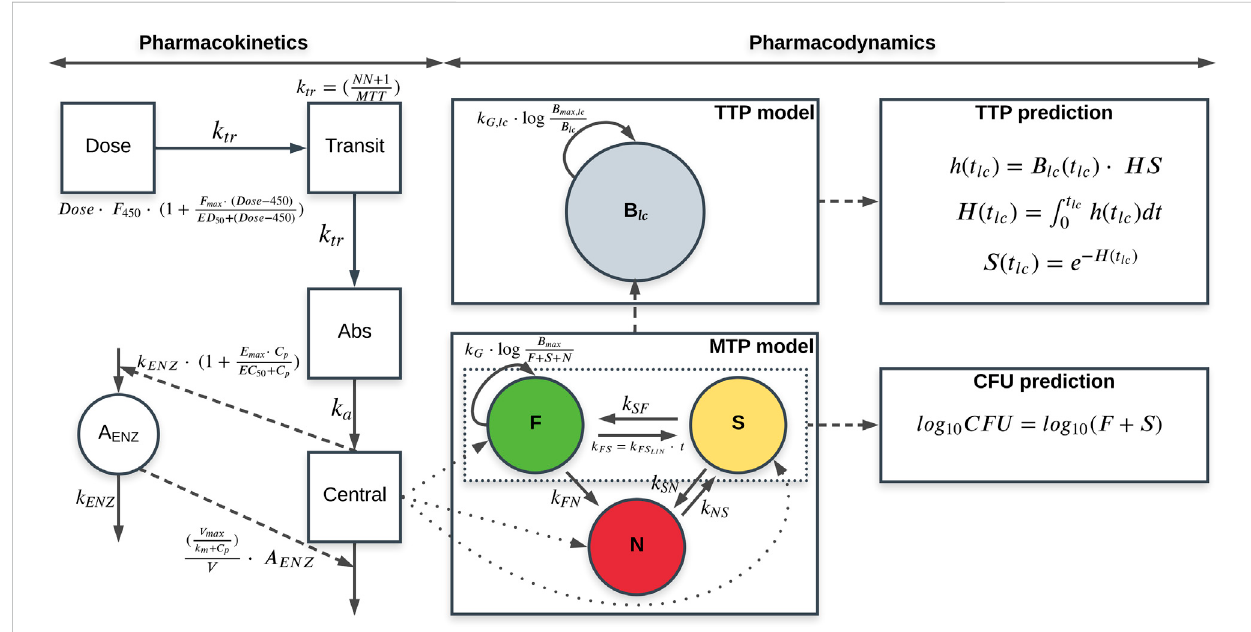
Schematicrepresentationofthe fi nalquantitativetuberculosisbiomarkermodel,includingthepharmacokinetic(PK)model(left),MTPmodel(lower middle)andtime-to-positivity (TTP)model(uppermiddle)usingearlybactericidalactivitydataofrifampicininmonotherapyintuberculosispatients.CFU and TTP observations are simultaneously informing the MTP and TTP models through the simultaneous fi t of the model to the data. The MTP model is represented by different bacterial sub-states;fast- (F), slow (S)and non-multiplyingsub-state (N).The PK model is linked to theMTP modelthrough the different killing parameters. CFU is predicted from the MTP model as thesum of theF and S sub-states. The TTP model consists of one bacterial sub- population model ( B lc ) which is the sum of the F, S, and N sub-states at the starting time in the liquid medium ( t lc = 0). The bacterial liquid culture at any given time point in the liquid medium [ B lc ( t lc ) ] was equal to the hazard h ( t lc ) multiplied by ahazard scaler ( HS ). The probability of aTTP sample without a positive signal at time t lc was given by the survival [ S ( t lc ) ] which was derived from the cumulative hazard [ H ( t lc )] . F 450 , relative bioavailability to 450 mg; F max ; NN , number of transit compartments; k tr , transfer rate F max , maximal increase in relative bioavailability; ED 50 , dose corresponding to half the between transit compartments; MTT , mean transit time; k a , absorption rate constant; k ENZ , fi rst-order enzyme degradation rate and zero-order enzyme formation rate; E max , maximal increase in enzyme formation rate; EC 50 , concentration corresponding to 50% of E max ; C p , plasma concentration; V max , themaximaleliminationrate; k m , C p athalfof E max ; V ,volumeofdistribution; k G ,growthrateofthefast-multiplyingstate; B max ,systemcarryingcapacity per mL -1 ; k FSLin , time-dependent linear rate parameter describing transfer from fast-to slow-multiplying states; k SF , fi rst-order transfer rate from slow-to fast-multiplying states; k FN , fi rst-order transfer rate between fast- and non-multiplying states; k SN , fi rst-order transfer rate between slow- and non- multiplying states; k NS , fi rst-order transfer rate between non- and slow-multiplying states; B lc , total bacterial liquid culture; B max , lc , system carrying capacity per mL -1 in liquid media; k G , lc , growth rate of the bacterial liquid culture; HS , hazard scaler; t , time since infection; t lc , time in liquid culture. Solid arrows represent mass transfer, while dashed arrows represent linking between